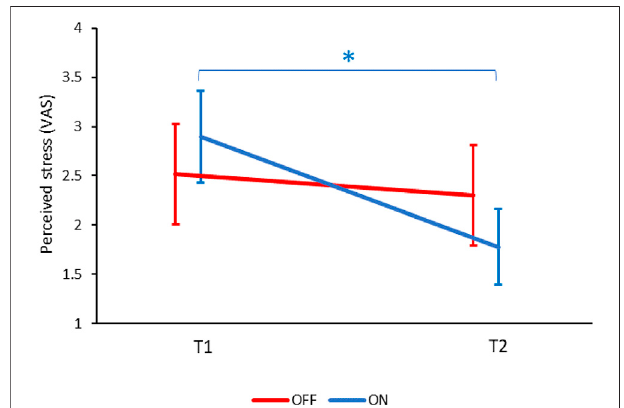
FIGURE3| ThechangeinperceivedstressbetweenBASELINE(T1)and TOUCH(T2)intheONandOFFgroups.OnlyintheONgroupperceivedstress decreased from T1 to T2 (* p < 0.05). Values denote mean visual-analogue scale(VAS)ratings(0 – 10)±SEM.ResultsfromtheONgrouparemarked in blue, and results from the OFF group are marked in red. T1 — before encountering PARO, T2 — while touching